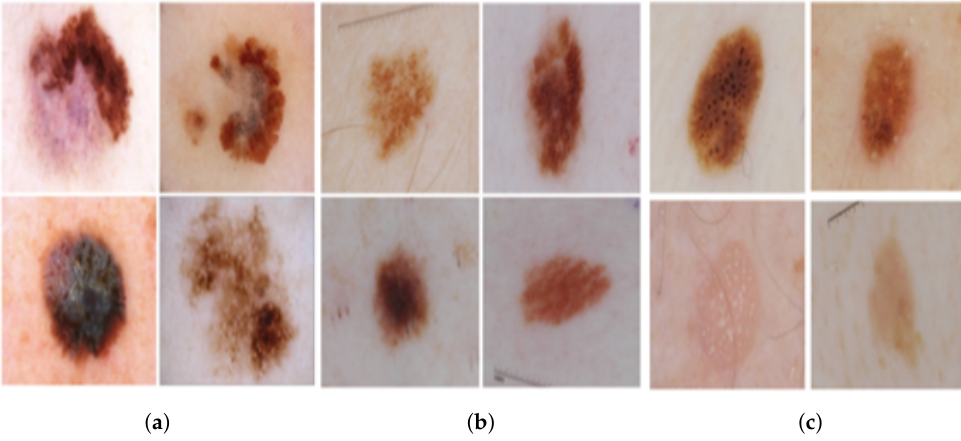
Figure 4. Different skin lesions examples of ISIC 2017: ( a ) melanoma, ( b ) nevus, and ( c ) sebor- rheic